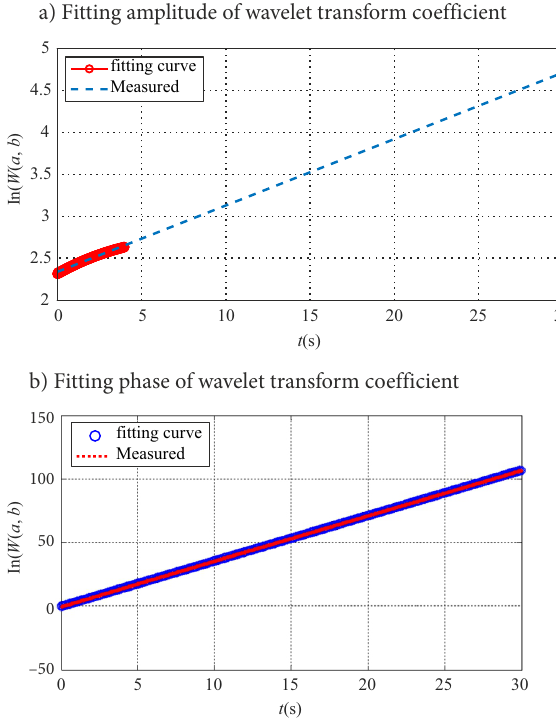
Figure 13. Fitting amplitude and phase of wavelet transform coefficient using